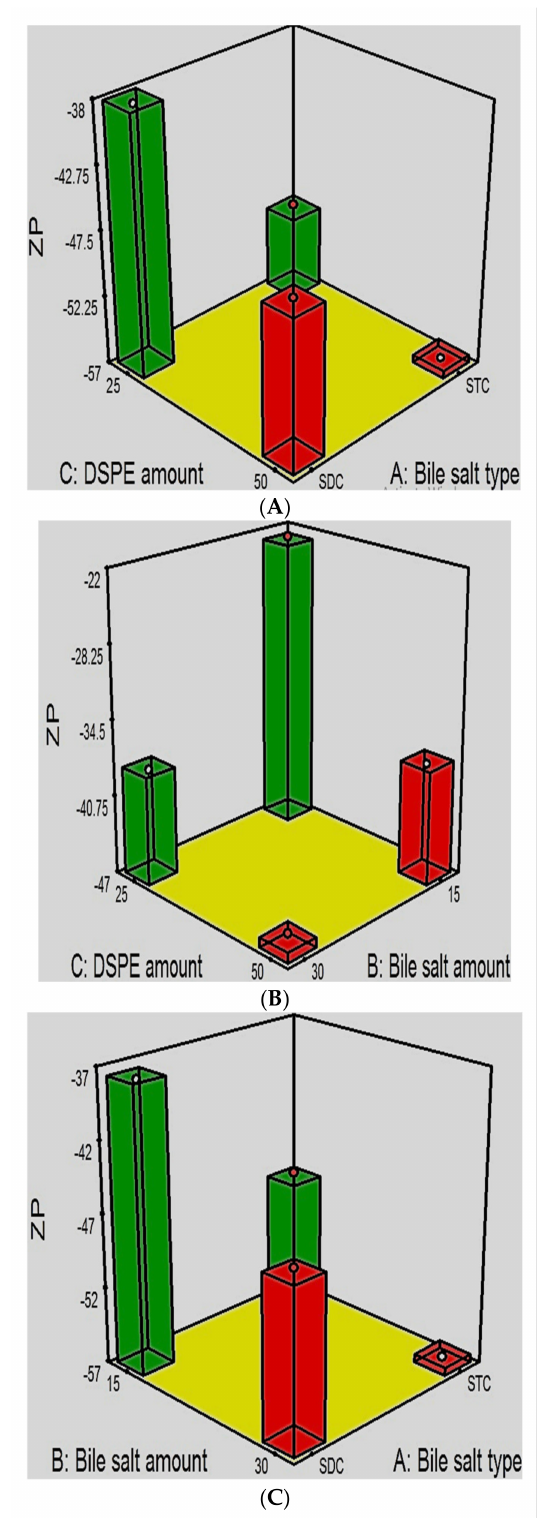
Figure 11. 3D surface response plots exploit the impact of ( A ) bile salt type, ( B ) bile salt amount and ( C ) DSPE–mPEG-2000 amount on ZP of 4e -loaded PEGylated bilosomes. ANOVA results revealed that by changing the type of bile salt (A), the formulae composed of STC exploited significant higher electronegativity ( p = 0.0261) than those composed of SDC, and this may be attributed to the difference in the number of OH